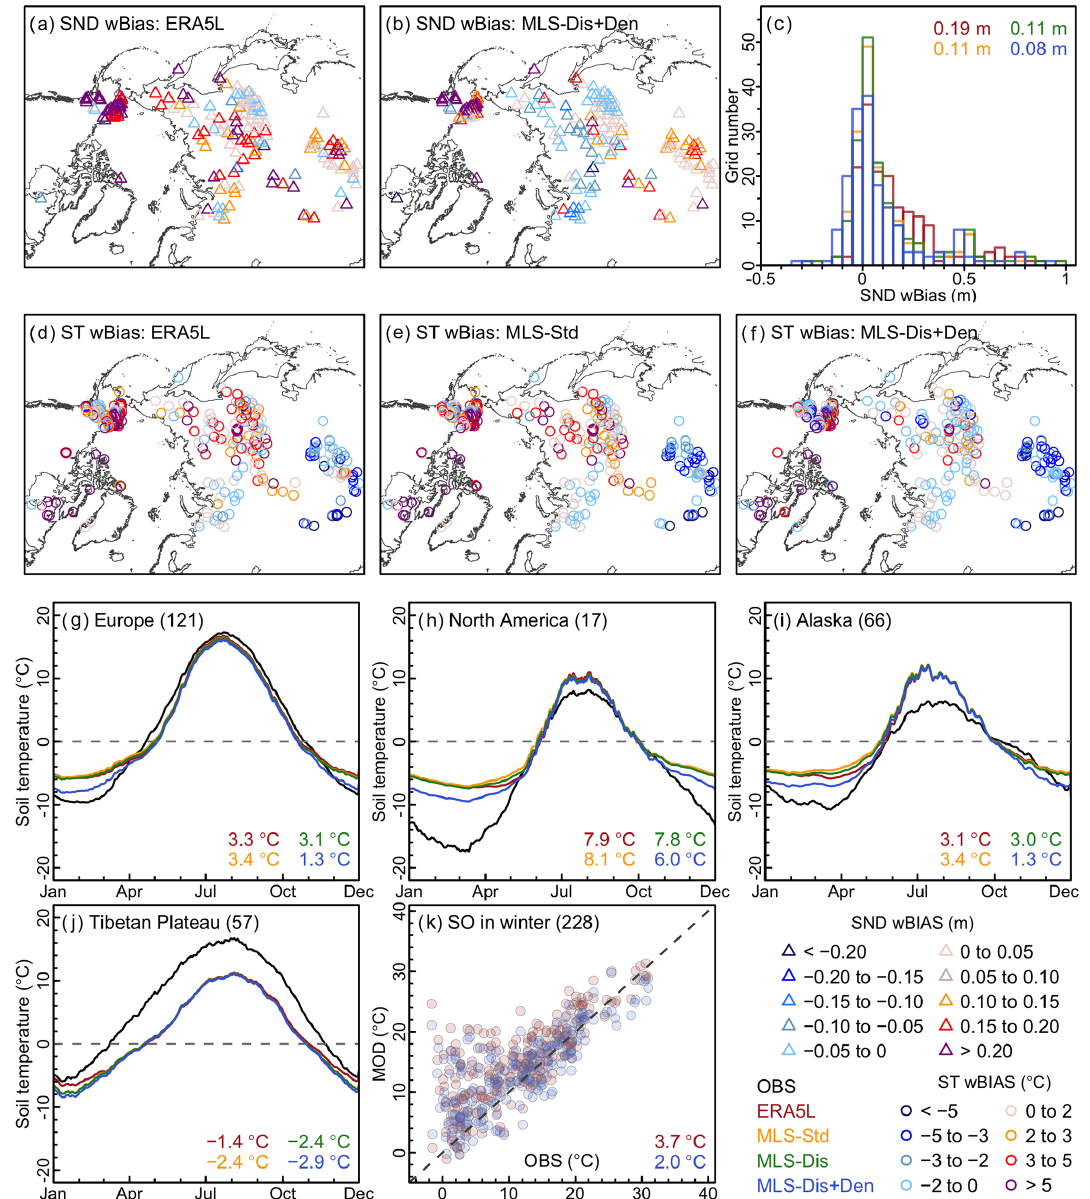
Figure 2. Evaluation of simulated snow depth and soil temperatures during 2001–2018. Weighted bias (wBias) of daily snow depth (SND) for ERA5-Land ( ERA5L, a) and Exp. MLS-Dis+Den (b) . The distribution of SND wBias for ERA5L and each simulation experiment (c) . wBias of soil temperature (ST) for 0.07–0.28m depth for ERA5L (d) , Exp. MLS-Std (e) , and Exp. MLS-Dis+Den (f) . Soil temperature for 0.07–0.28m depth in different permafrost regions (g–k) , and winter (DJF) surface offset ( SO, k) . The number of unique grid cells where observed sites are located is given in the bracket. Color numbers are estimated snow depth and soil temperature bias in winter for observation (OBS) and each simulation experiment. Time series of specific sites are available in the